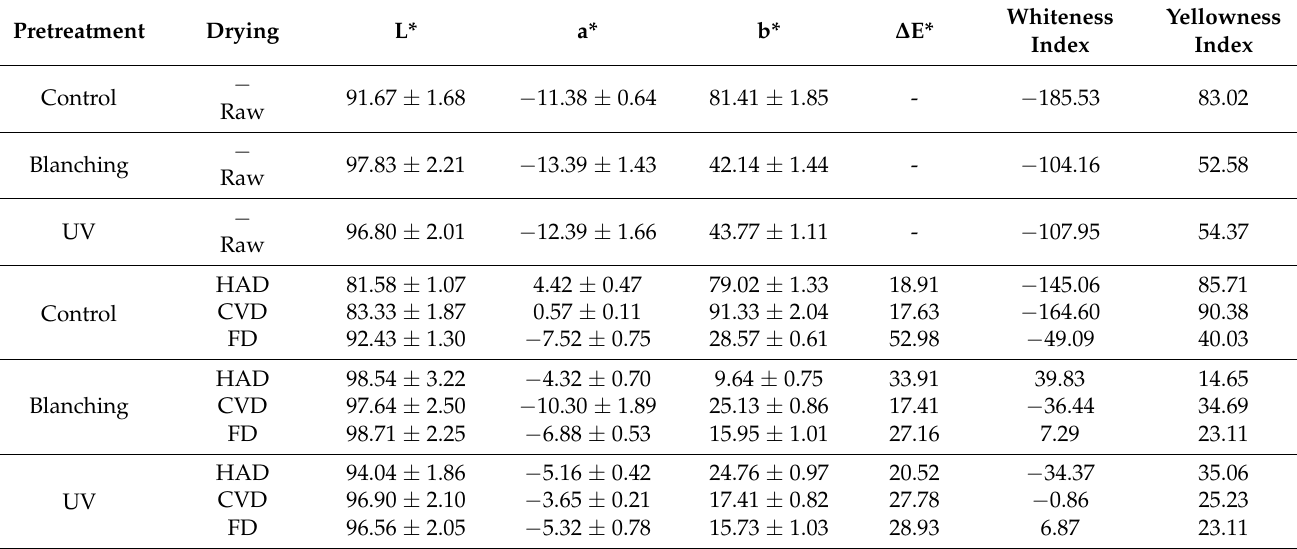
Table 2. The color characteristics and changes of B. edulis mushrooms under various pretreatment and drying